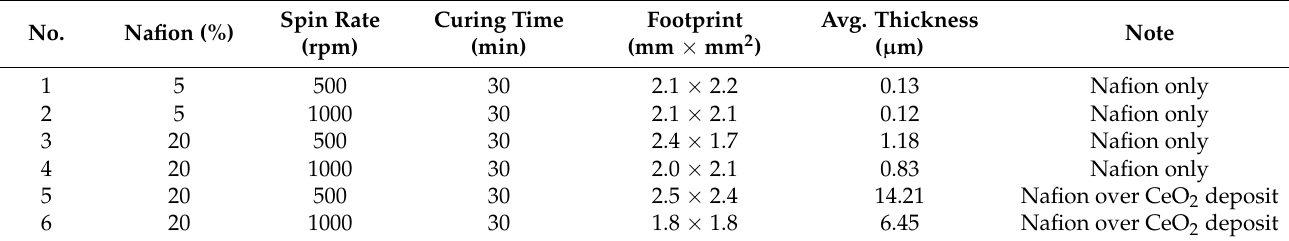
Table 1. Nafion membrane fabrication conditions for thickness